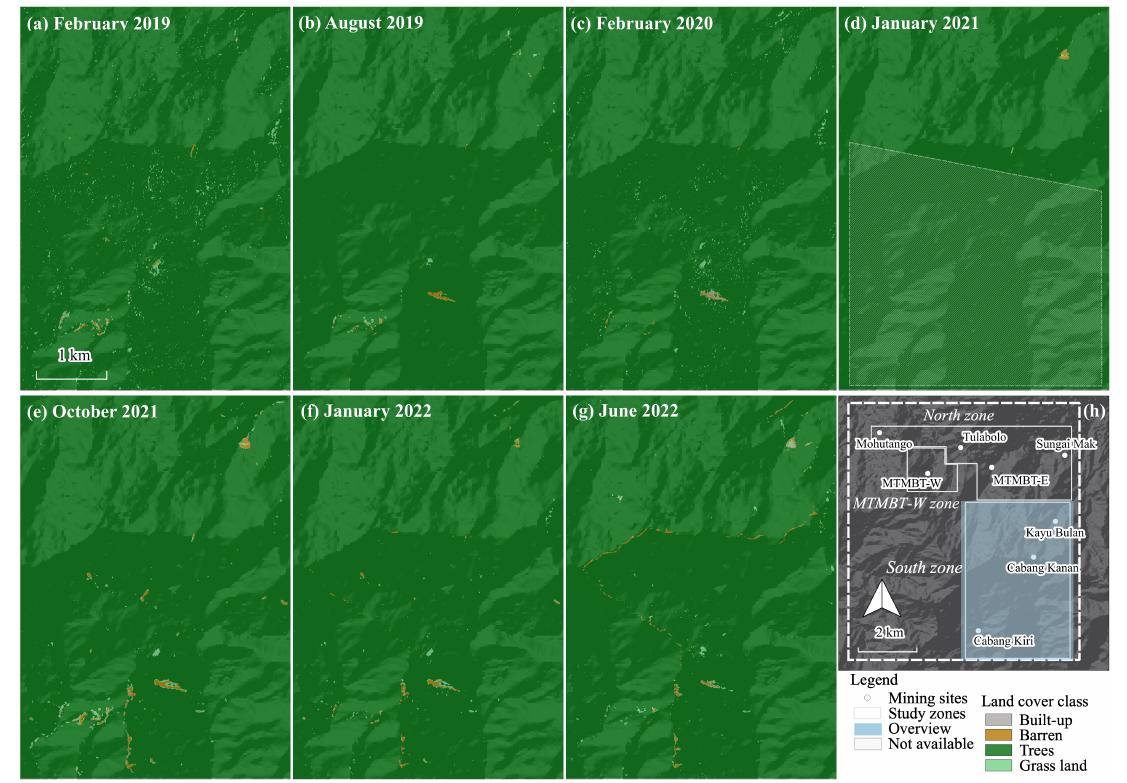
Figure 4. Landcover classification using PlanetScope series. ( a – g ) Landcover transformations in the south zone (2019–2022); ( h ) overview of the target zone.